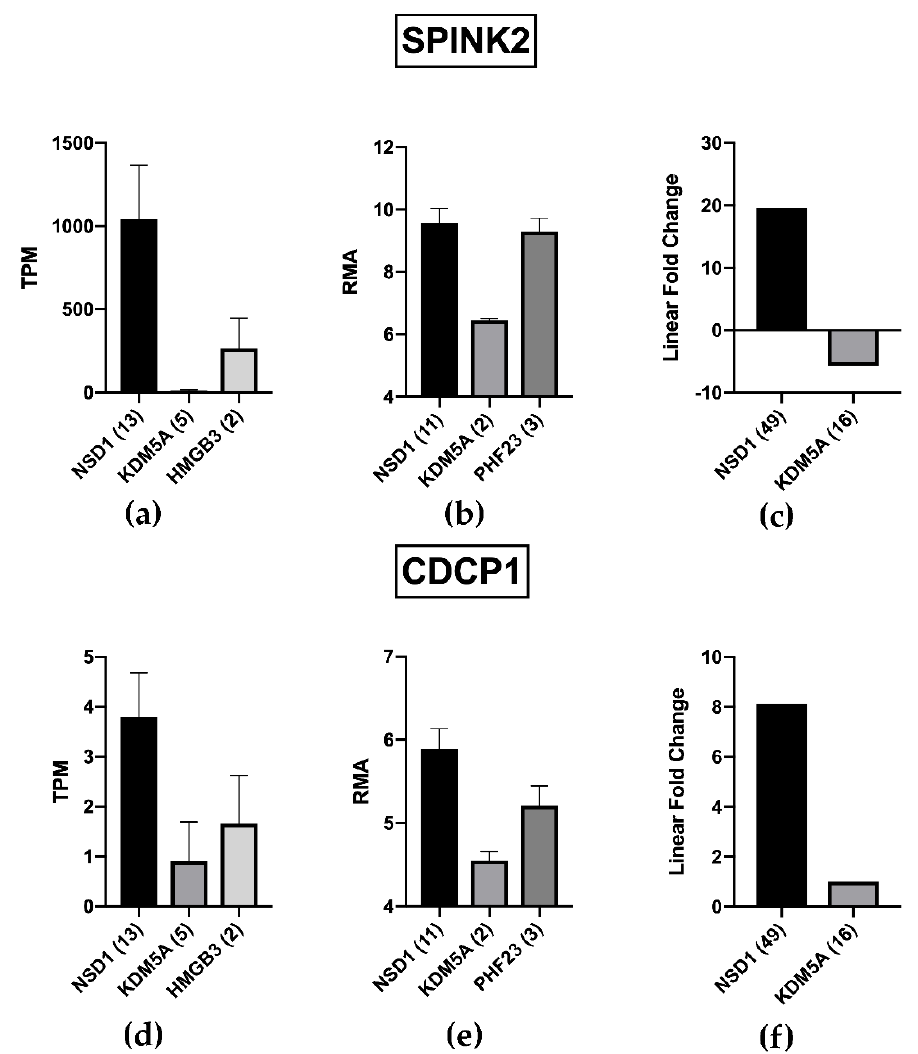
Figure 5. SPINK2 and CDCP1 are differentially expressed depending on NUP98r. ( a , d ) TARGET study shows a significant upregulation of SPINK2 and CDCP1 in presence of NUP98-NSD1 rearrangement, whilst in the first one it is almost absent in patients with NUP98-KSM5A fusion. ( b , e ) GSE75461 cohort establishes the higher expression of SPINK2 and CDCP1 in patients with NUP98-NSD1 compared with NUP98-KDMA5 rearrangements, revealing also a comparable expression of SPINK2 in presence of NUP98-PHF23 translocation. ( c , f ) Noort’s study confirms that SPINK2 and CDCP1 are dramatically upregulated in presence of NUP98-NSD1 rearrangement. For CDCP1 no significant difference in Fold Change between KDMA5+ and KDMA5 − has been reported by Noort et al. We indicated a Fold Change = 1 to allow a visual comparison.